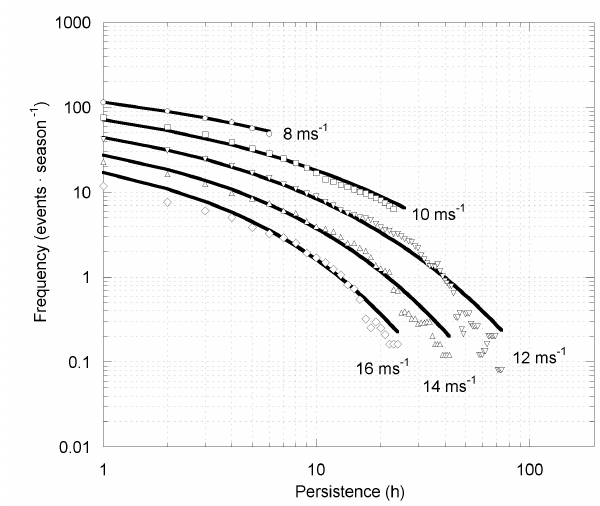
F IG . 4. – Logarithmic plot of frequency expressed as events per sea- son against their persistence in hours for Deltebre station. Points are measured frequencies of events with the following mean values: 8 ms -1 (circles), 10 ms -1 (squares), 12 ms -1 (downward triangles), 14 ms -1 (upward triangles) and 16 ms -1 (diamonds). Lines are modelled frequencies using Eq.8.